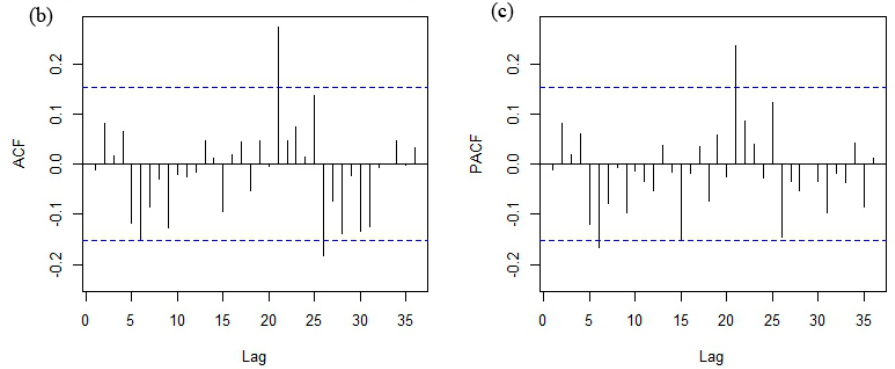
Figure 9. Residuals and their autocorrelations in karamatsu ARIMA model: ( a ) Plot of residuals; ( b ) autocorrelations with lags of up to 36 for the sugi log prices; ( c ) partial autocorrelations with lags of up to 36 for the sugi log prices.